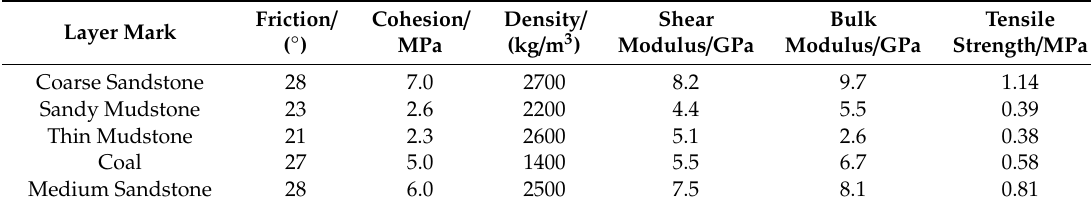
Table 1. Rock mechanics parameters of the coal seam roof and